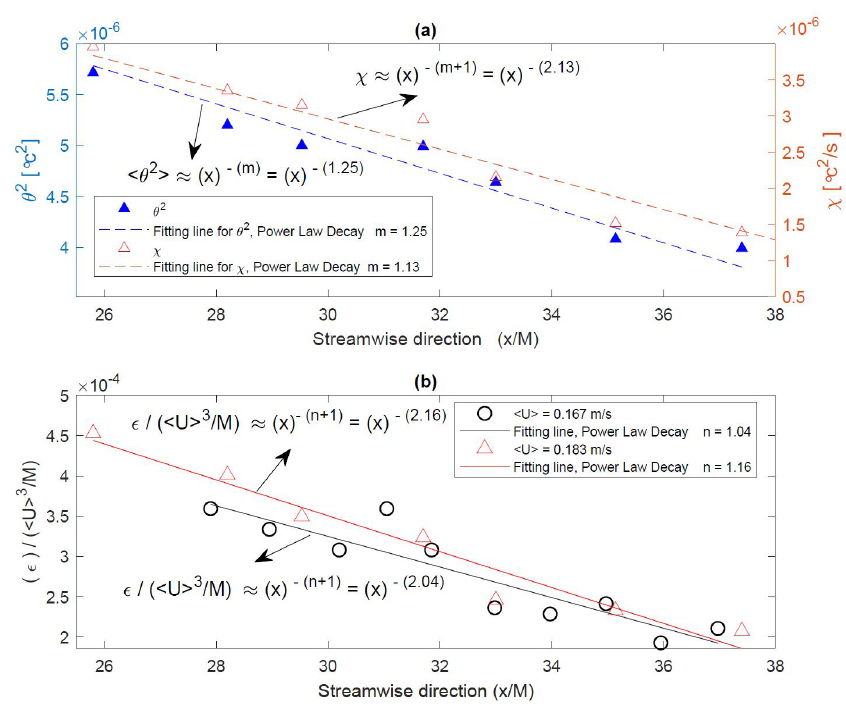
Figure 3. ( a ) Temperature variance ( θ 2 ) and χ values along the streamwise direction are shown. The dashed blue and brown lines are fitting lines of the θ 2 and χ profiles, respectively. The mean flow velocity was < U > = 0.183 m s − 1 . ( b ) The normalized value of (cid:101) / ( < U > 3 / M ) along the streamwise direction is shown. The black and red lines are fitting lines of the data for 0.167 m/s and 0.183 m/s, respectively. The data were collected at z = 0.25 m. The heated-grid power was P 0 = 8.3 kW for both graphs